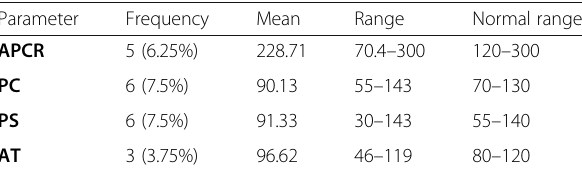
Table 3 Results of screening tests of inherited thrombophilia in the case